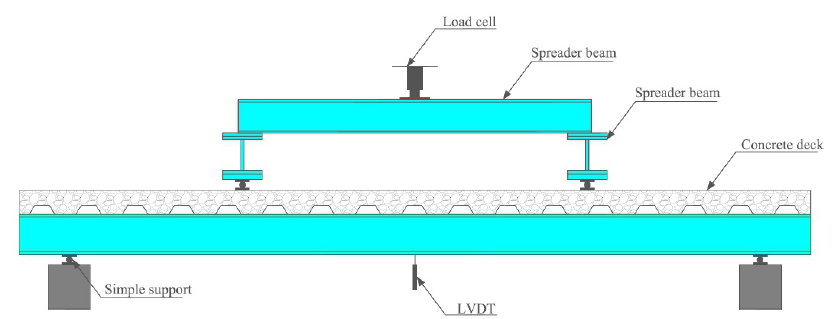
Figure 1. Composite concrete–steel beam test